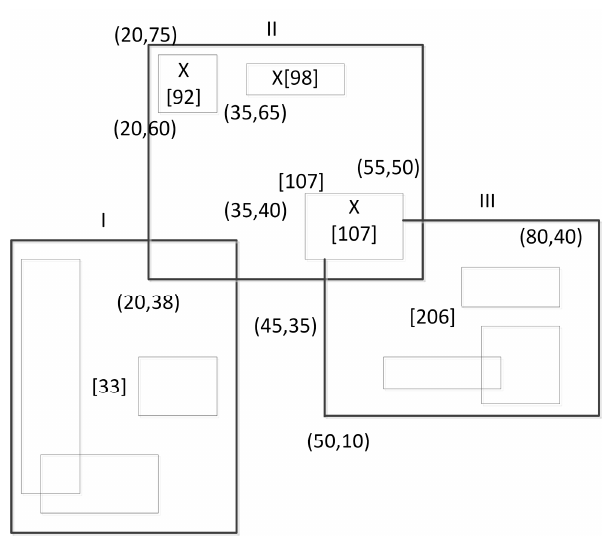
Figure 3. Two-dimensional Hilbert index space division.